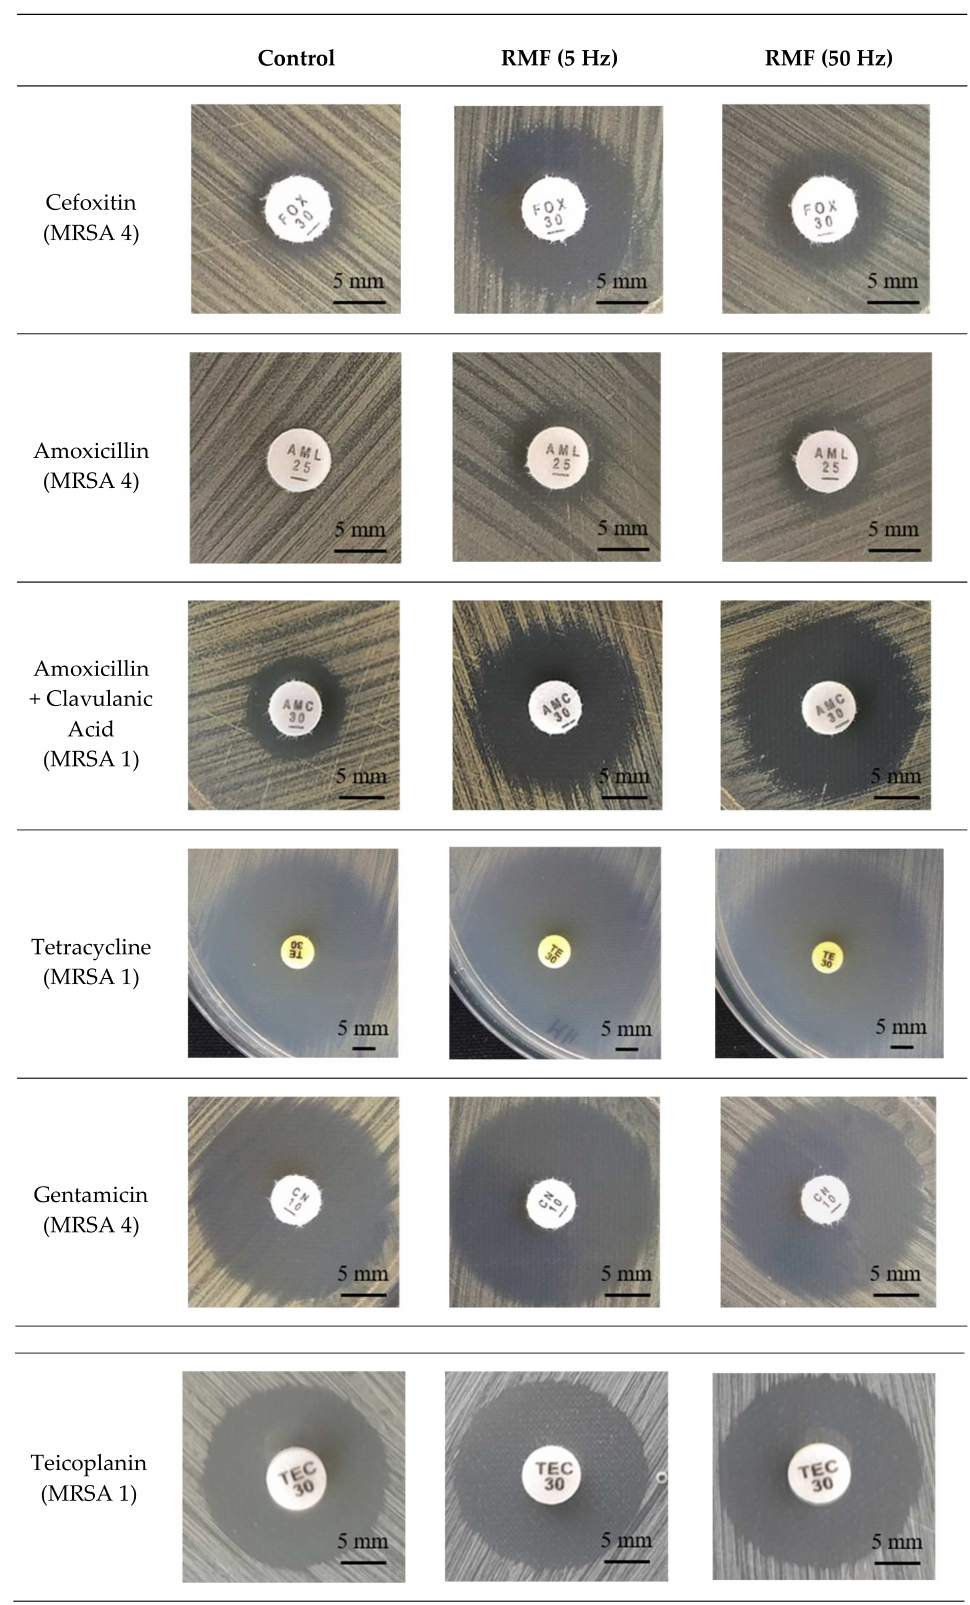
Figure 1. Representative pictures of growth inhibition zones (mm) in control and RMF-exposed MRSA cultures around discs with different